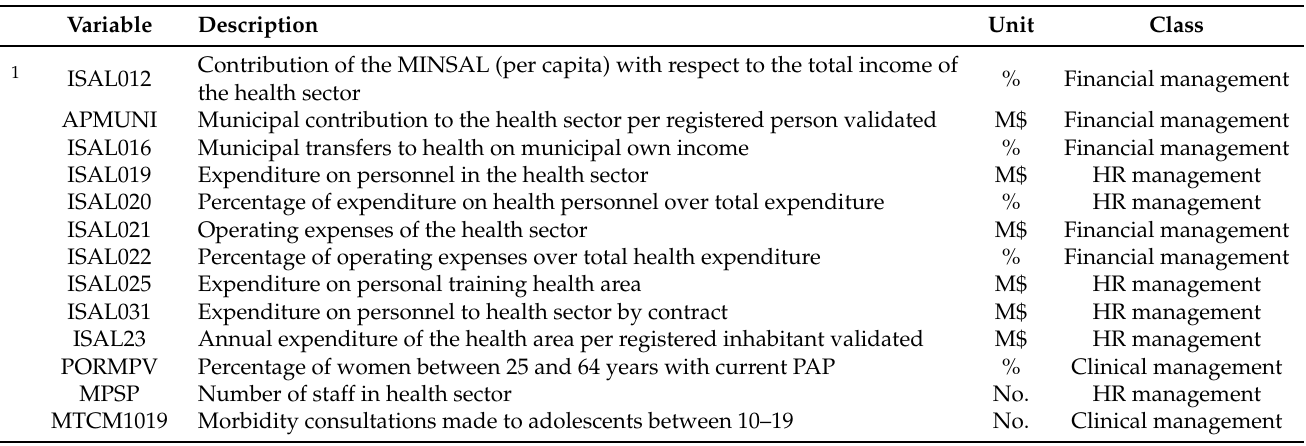
Table 2. Description of variables, taken from